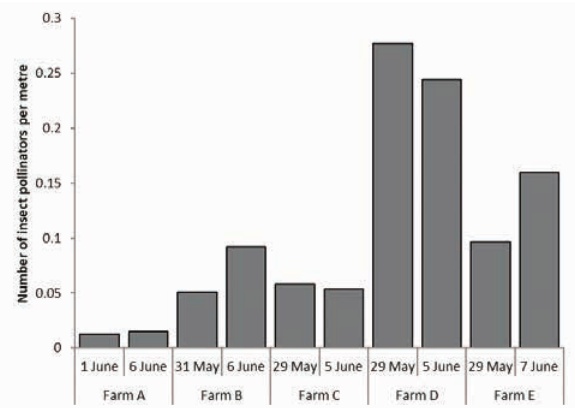
Figure 3: Abundance of floral visitors at each farm during each